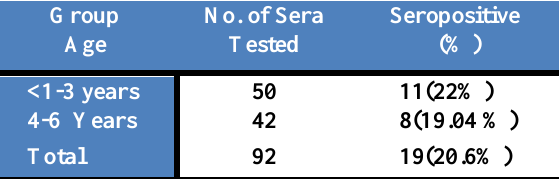
Table, 7: Prevalence of T. gondii in camels by using ELISA according to age